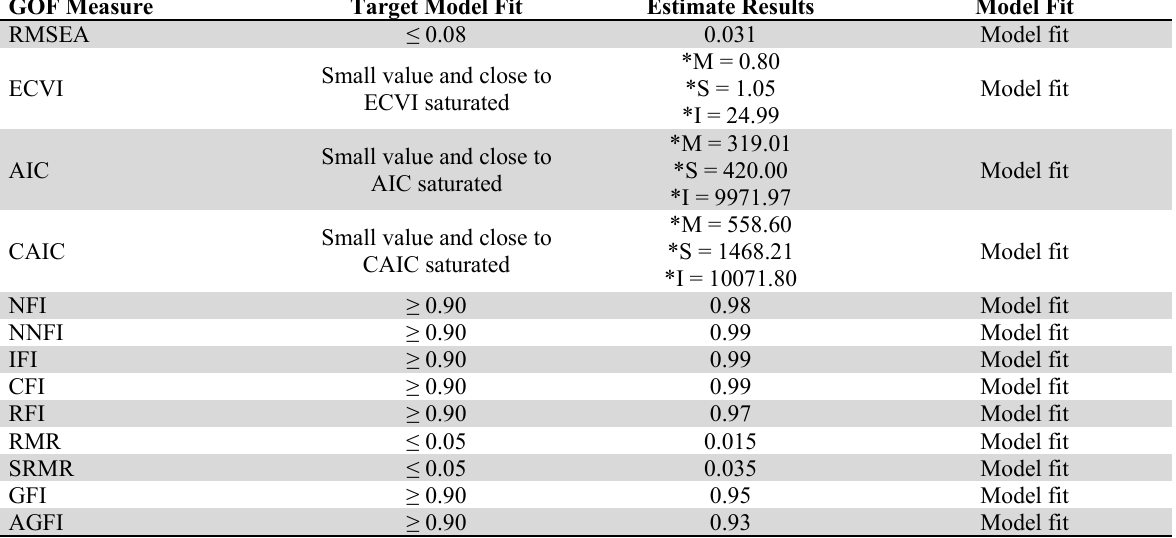
Goodness of Fit Model